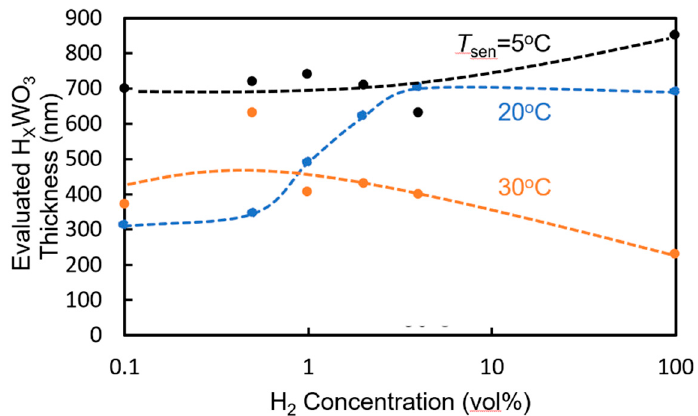
Figure 12. Relationship between the evaluated thickness of the H x WO 3 layer on the surface side and